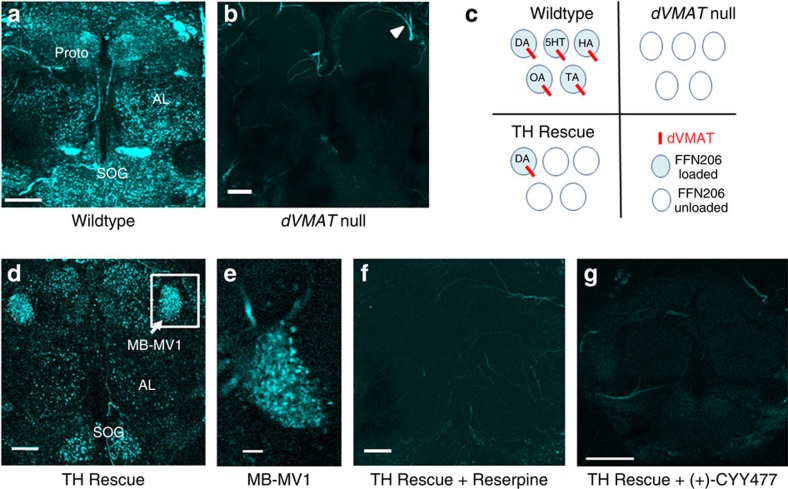
FFN206 accumulation is dependent on dVMAT and selectively labels presynaptic DA nerve terminals in adult fly TH Rescue brain.(a) Multiphoton microscopy of FFN206-loaded adult WT brain revealed extensive presynaptic monoaminergic nerve terminal labelling in the central brain neuropil, accumulating in puncta <1 μm diameter. Labelled regions include the suboesophageal ganglion (SOG), antennal lobe (AL) and the protocerebrum (Proto). (b) Absence of dVMAT expression in brains of dVMAT null mutants abolished virtually all neuropil FFN206 labelling. Residual signal was primarily autofluorescence from tracheal structures (triangle)74 as well as some variable staining outside the neuropil. (c) Schematic illustration of the expected monoamine content of FFN206-loaded vesicles (blue fill) in WT, dVMAT null and TH Rescue brains. (d) FFN206 selectively labelled presynaptic dopamine nerve terminals in adult TH Rescue brain with particular enrichment in MB-MV1 neurons (arrow and white box). (e) Single-plane image of MB-MV1 as labelled by FFN206 in a TH Rescue brain. (f) Reserpine pretreatment of an adult TH Rescue brain prevented FFN206 labelling, similar to dVMAT null brain (b). (g) FFN206 labelling of adult TH Rescue brain was similarly blocked by pretreatment with (+)-CYY477 (1 μM, 20 min, 25 °C) (compare with f). String-like structures in e–g are autofluorescent trachea. Comparable results were obtained from N⩾3 independent experiments. Images are from projected Z series of coronal sections acquired with similar settings and of comparable depth; all scale bars are 25 μm, except for e (Scale bar, 5 μm). λex=820 nm, λem=460/50 nm FWHM.